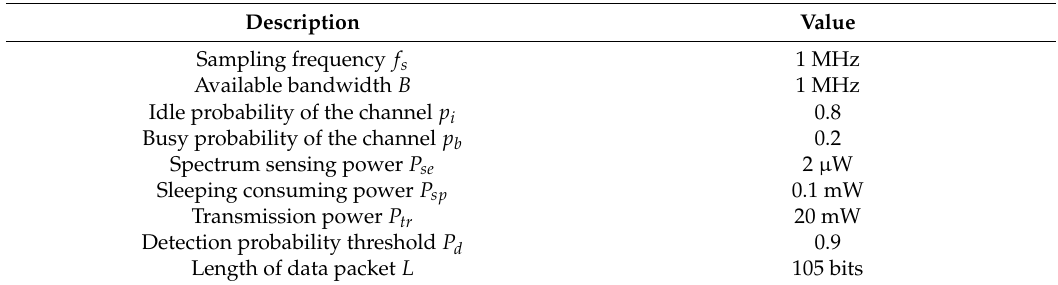
Table 3. Simulation